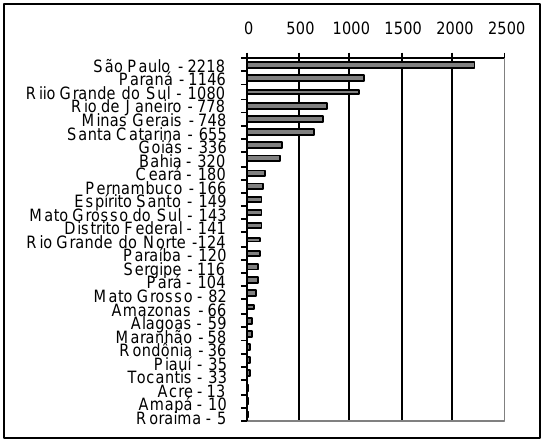
Figura 7. Especialistas por unidades da federação. Fonte: Portal da Inovação. Acesso em: 30/12/2006. Por região, verifica-se um predomínio do sudeste do sul na concentração de especialistas, que estão assim distribuídos: região sudeste (42%), região sul (30%), região nordeste (13%), região centro-oeste (8%) e região norte (4%) (Figura 8).